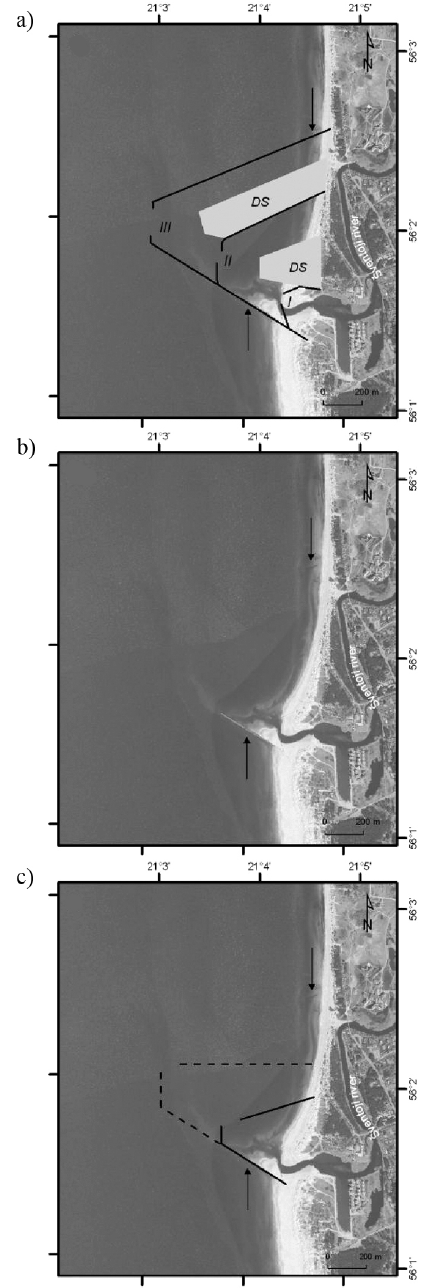
Fig. 2 . Šventoji port development: a) construction and